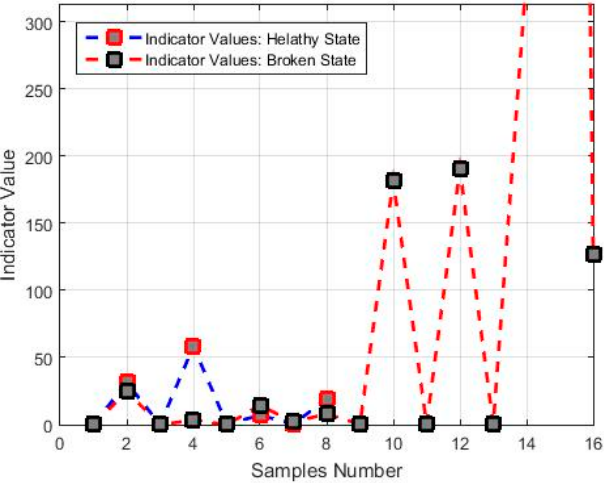
Figure 10. Values of the indicator in the time domain for all the samples used in the experiments. Table 10. Results of the indicatorin the time domain, based on Equations (6)–(8), for the data of the experiments with the healthy motor during startup.